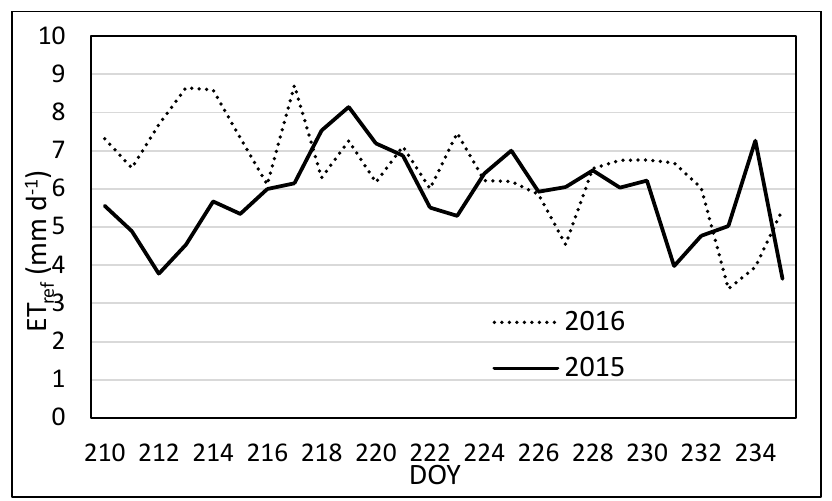
Figure 9. Daily ET ref for the same DOY in 2015 and 2016, used as an indicator for differences in weather parameters.